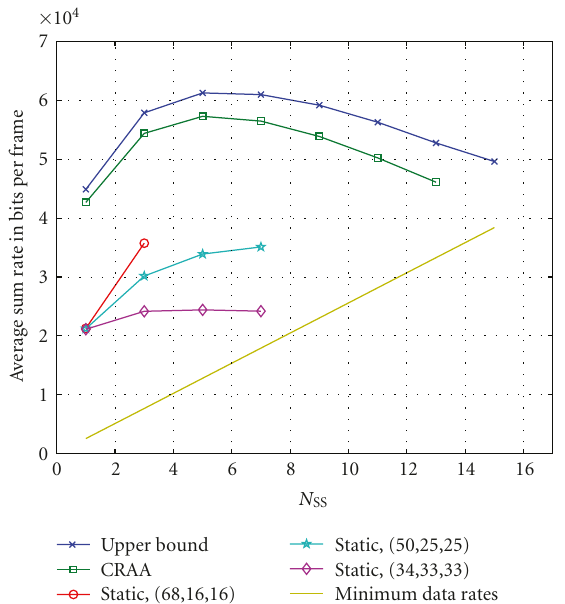
Figure 5: Average sum rate of resource allocation algorithms depending on the number of SSs. The minimum data rate is 2560 bits per frame.